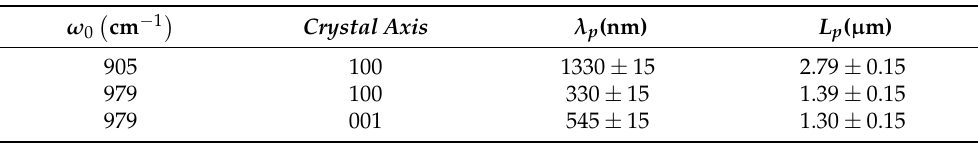
Figure 1. ( a ) Schematics of the experimental setup employed to image propagating PhPs in a α -MoO 3 flake transferred on a SiO 2 substrate. A gold rod-like nanoantenna is used to confine the incident infrared light with p-polarized field E 0 , which allows the excitation of PhPs. The near-field signal on the surface of the slab is scattered by a metallic tip and detected by a distant detector. ( b ) Experimental near-field amplitude images ( s 3 ( x , y )) launched by the nanoantenna in a 225-nm-thick (see Appendix A) α -MoO 3 flake at illuminating frequencies ω 0 = 905 cm − 1 (hyperbolic regime, top panel) and ω 0 = 979 cm − 1 (elliptic regime, bottom panel). ( c ) Experimental profiles (dots) taken along the [100] and [001] directions denoted by dashed lines in ( b ). The fit to the experimental data is depicted with a black solid line. Table 1. Wavelengths ( λ p ) and propagation lengths ( L p ) obtained from the experimental profiles shown in Figure